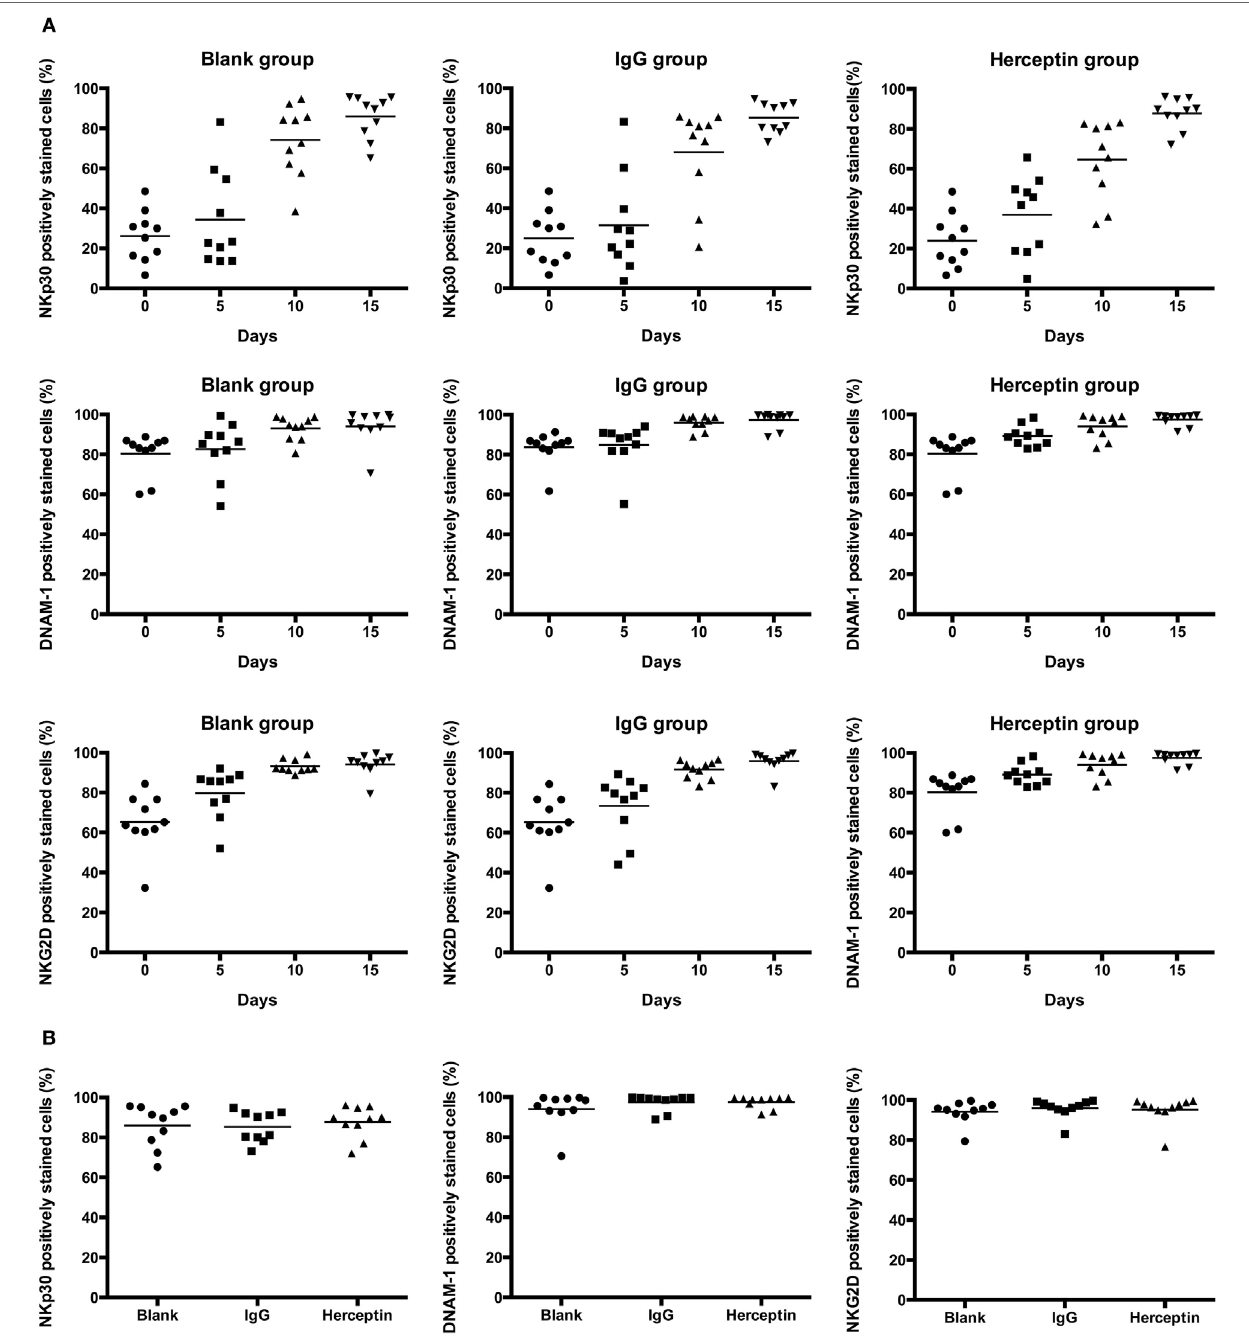
FigUre 4 | Expression of the cytotoxicity-associated activated receptors, including NKp30, NKG2D, and DNAM-1, in NK cell subsets among the final expansion products cultured in three different environments. Expression in electronically gated CD3 − CD56 + NK cells was analyzed by FCM. (a) Changes in the expression of each receptor over 15 days. (B) The expression of each receptor on the final expanded NK cells among three groups is shown. The results are presented as the means of 10 patients and error bars represent the